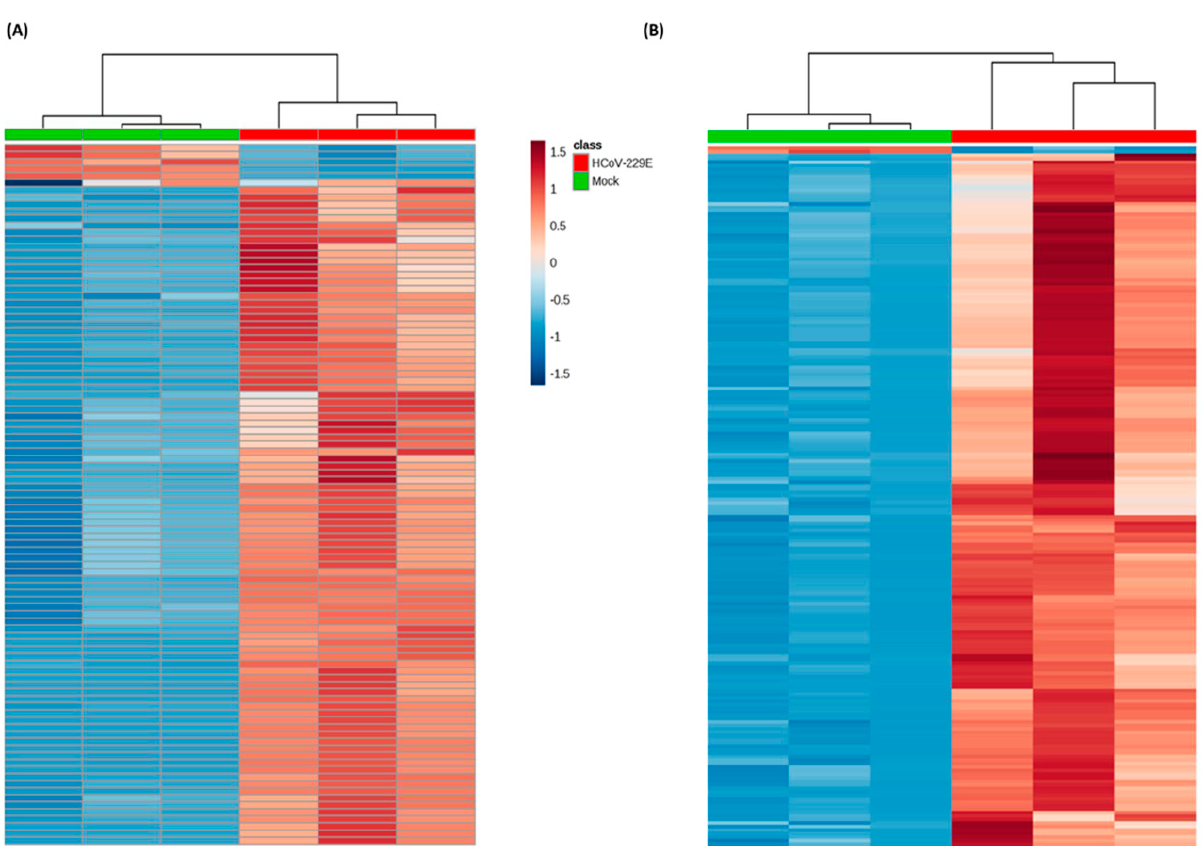
Figure 1. Heatmap showing the lipidomic analysis of human coronavirus 229E (HCoV-229E)-infected versus non-infected Huh-7 cells. Each rectangle represents an ion feature colored by its normalized intensity scale from blue (decreased level) to red (increased level). The dendrogram on the top was constructed based on the lipid intensity (similarity measure using Euclidean, and the Ward clustering algorithm). HCoV-229E, HCoV-229E-infected cells; Mock, non-infected cells. ( A ) Significant ion features in negative detection mode; ( B ) significant ion features in positive detection mode.